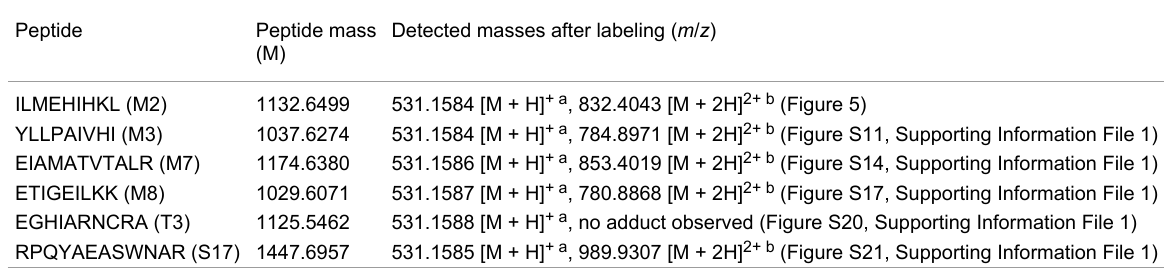
Table 2: ESIMS data of peptide labeling with ligand 3 (cf. Supporting Information File 1 for all details).